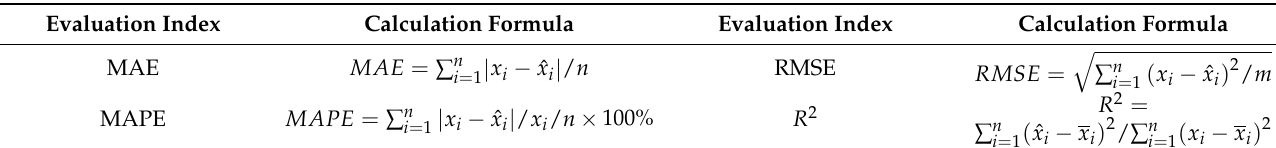
Table 1. Performance evaluation index of model.